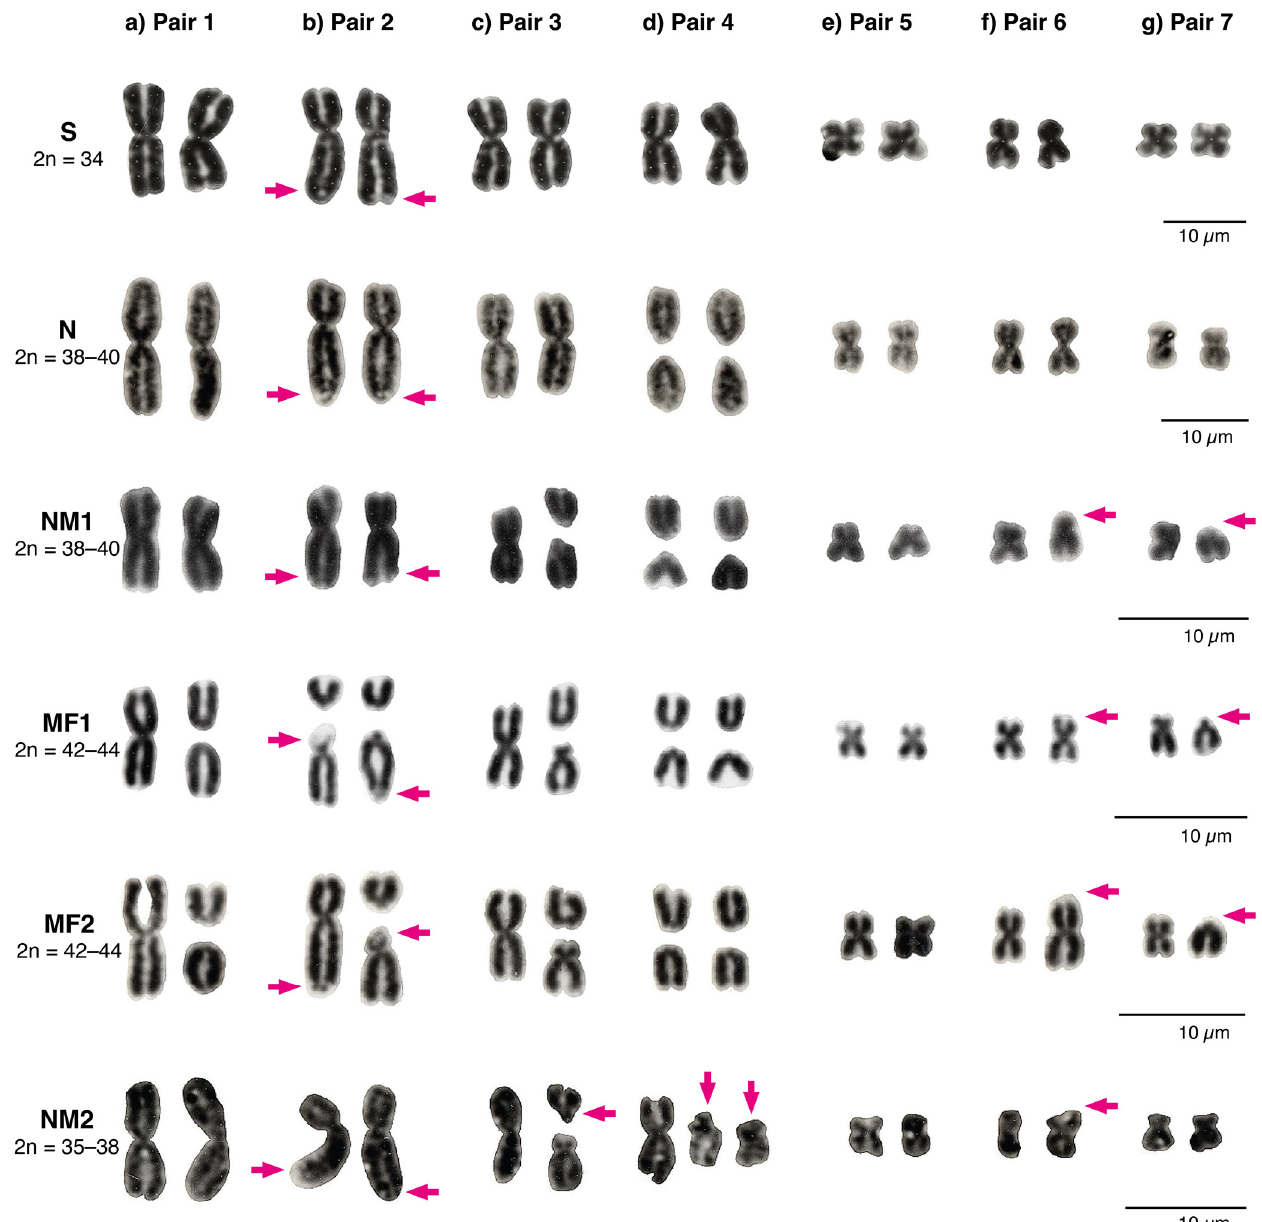
Figure 3. Representation of partial karyotypes for the six macrochromosome pairs (pair 1 to 6) and microchromosome pair 7 of the six chromosome races of L. monticola . ( a ) Metacentric pair 1. For the following cases, the arrow depicts; ( b ) the NOR position in pair 2; ( c ) the subacrocentric fission product in pair 3; ( d ) the submetacentric chromosomes in pair 4; ( e ) monomorphic for the submetacentric pair 5; ( f ) the enlarged pair 6; and ( g ) the pericentric inversion in pair 7. Individuals whose chromosomes are shown are: L1085 (S race), L547 (N race), L2651 (NM1 race), L2180 (MF1 race), L1362 (MF2 race), and L730 (NM2